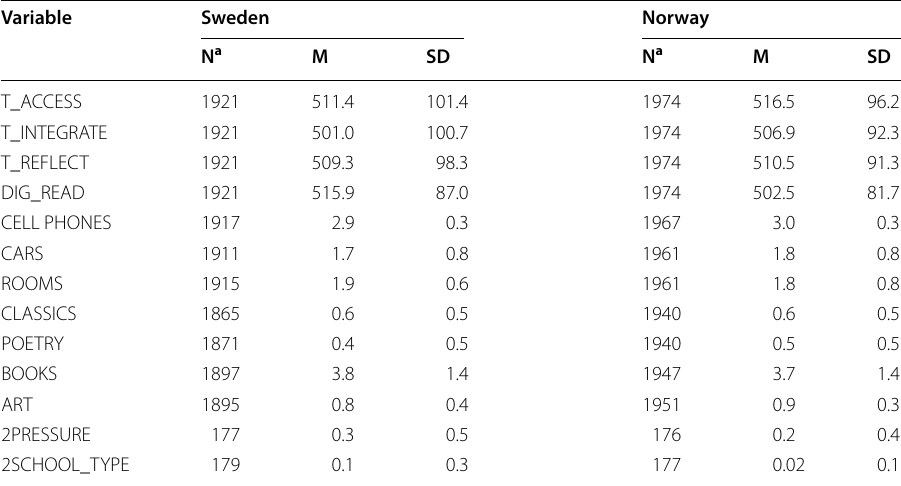
Table 3 Number of observations, means and standard deviations for the manifest vari-